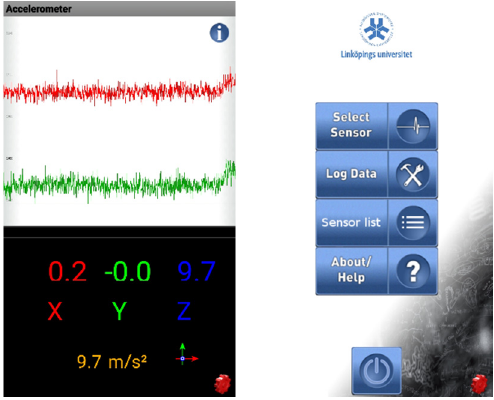
Figure 8. Snapshot of the sensor fusion app screens.